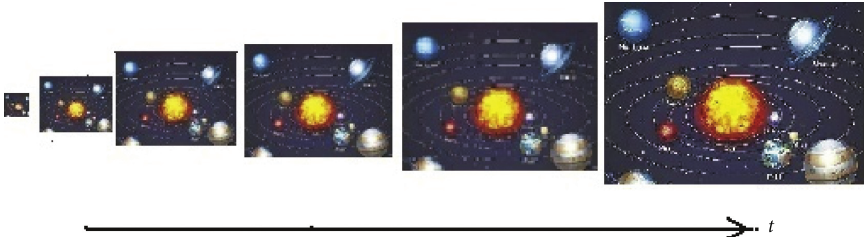
Figure 2: Schematic diagram of the growth process of the solar system with time.